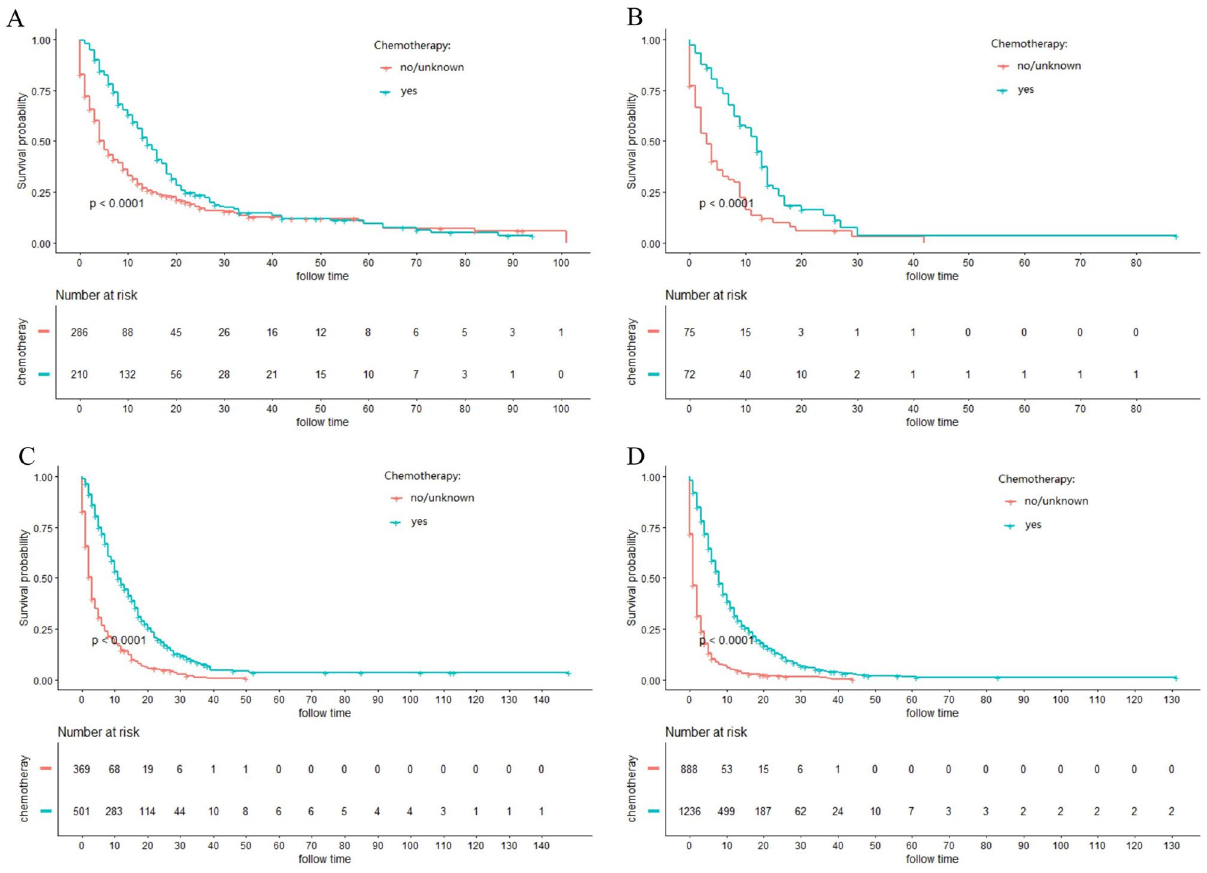
Figure 3. Kaplan–Meier curves for cancer-specific survival (CSS) in different AJCC stage between chemotherapy and no-chemotherapy groups in unresectable ICC patients: ( A ) stage I; ( B ) stage II; ( C ) stage